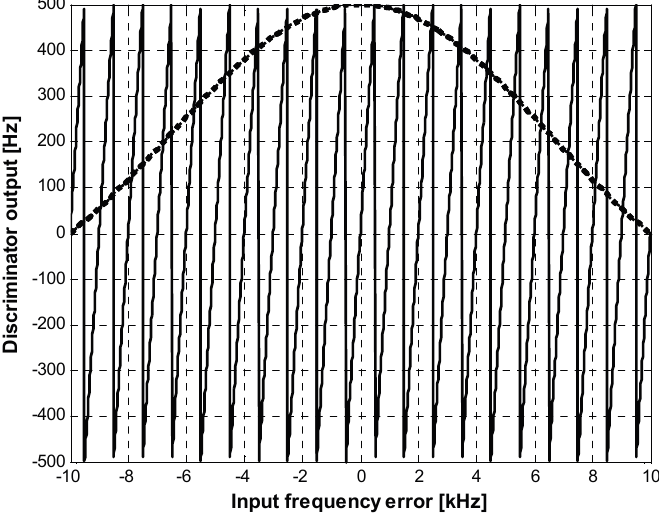
Figure 7. Tracking loop discriminator vs. correlator